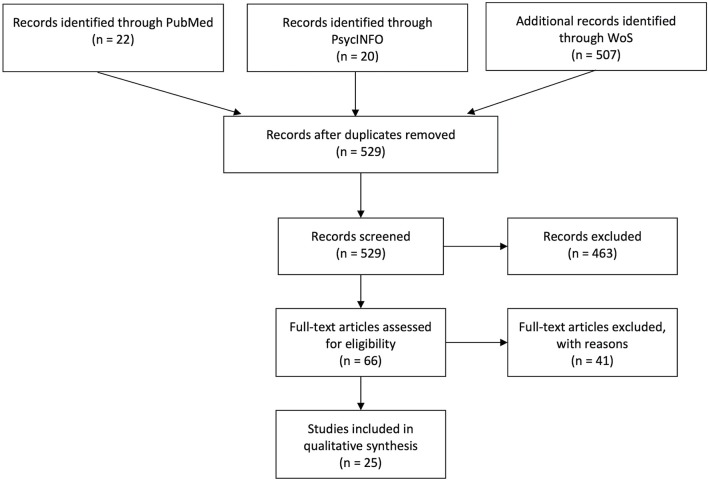
PRISMA flow chart.